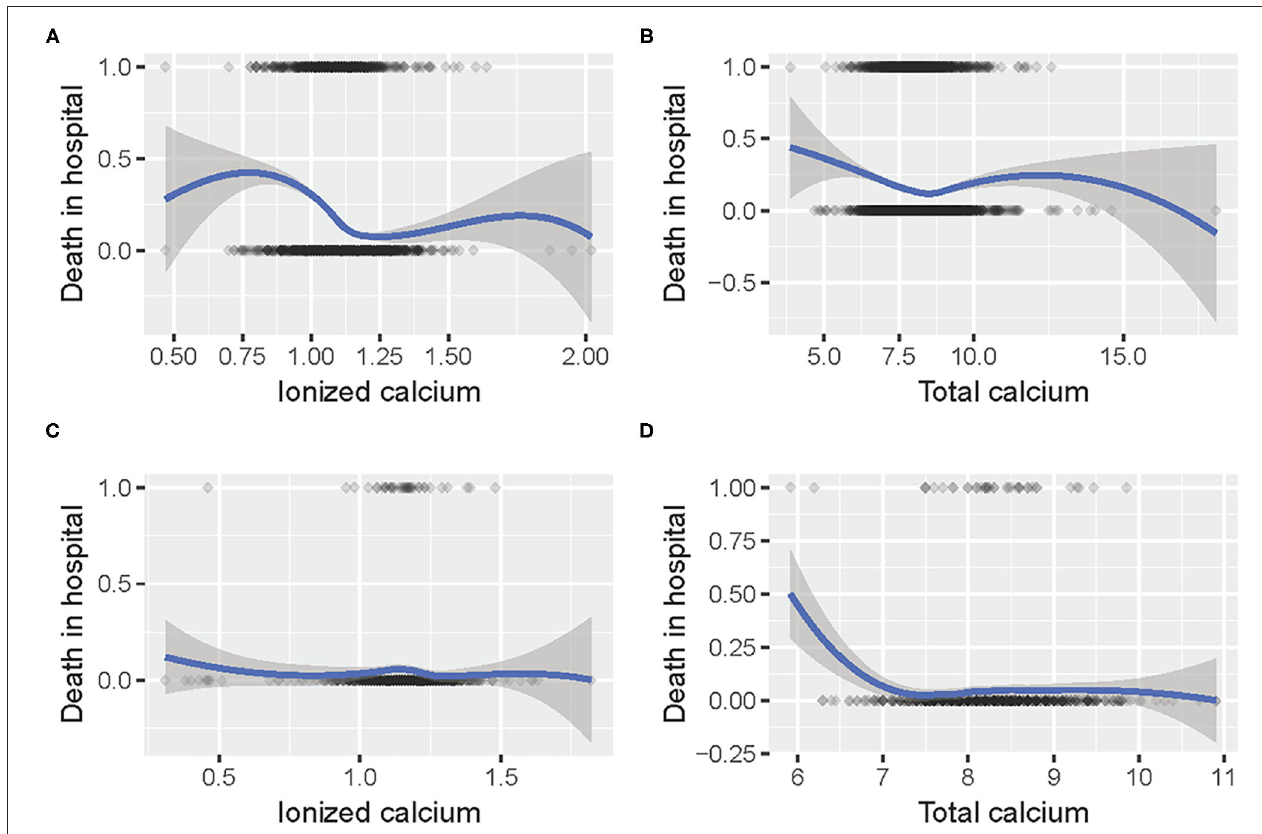
FIGURE 2 | The relationship between (A) iCa and mortality in hospital in MIMIC III; (B) tCa and mortality in hospital in MIMIC III; (C) iCa and mortality in hospital in eICU; (D) tCa and mortality in hospital in